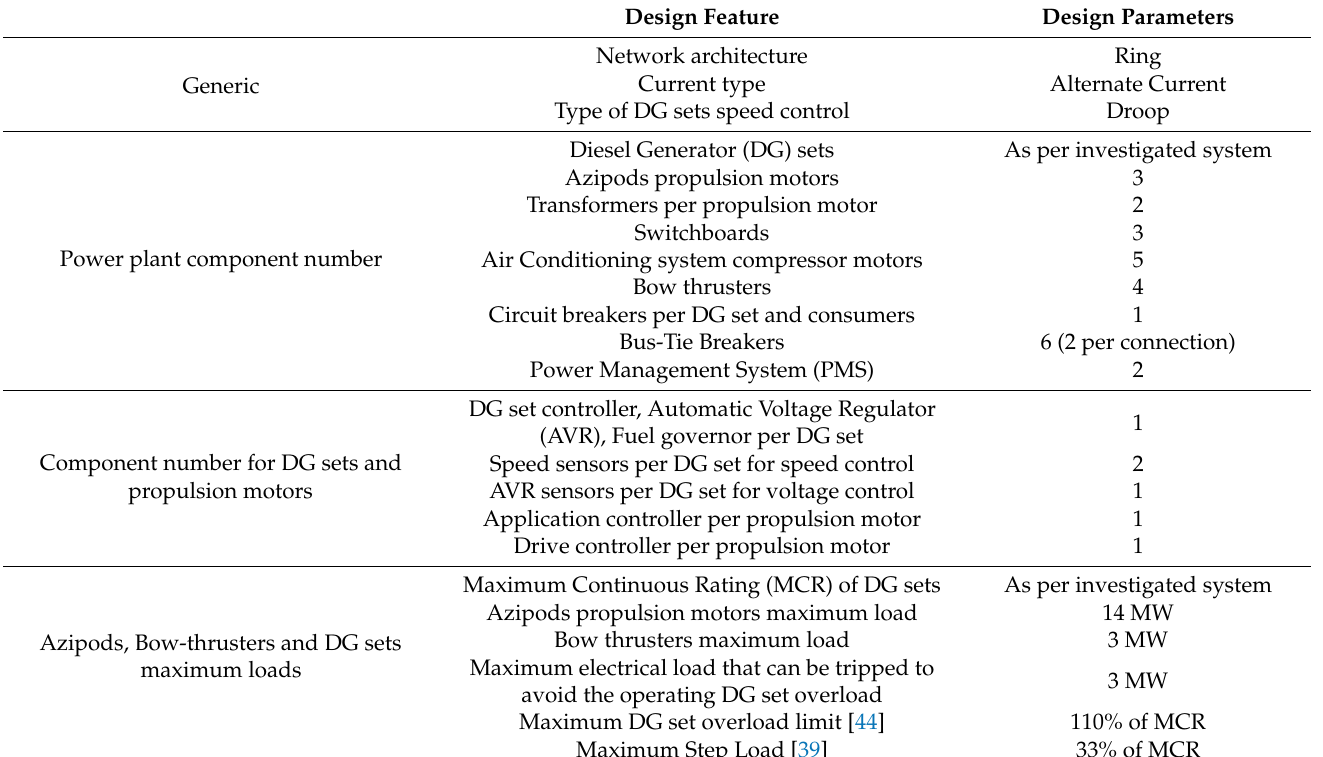
Figure 2. Cruise ship power plant network control structure (red box is used to depict the boundaries of the investigated system). Table 1. Used cruise ship propulsion system design parameters.